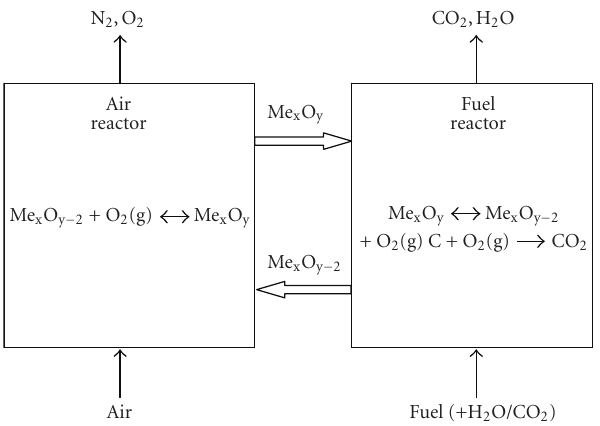
Figure 8: Principal layout of chemical-looping oxygen uncoupling. The oxygen carrier is denoted by Me x O y and Me x O y − 2 , where Me x O y is a metal oxide and Me x O y − 2 is a metal or metal oxide with lower oxygen content. Here, the fuel is carbon. The fuel reactor could be fluidized using recirculated CO 2 or steam when burning solid fuel